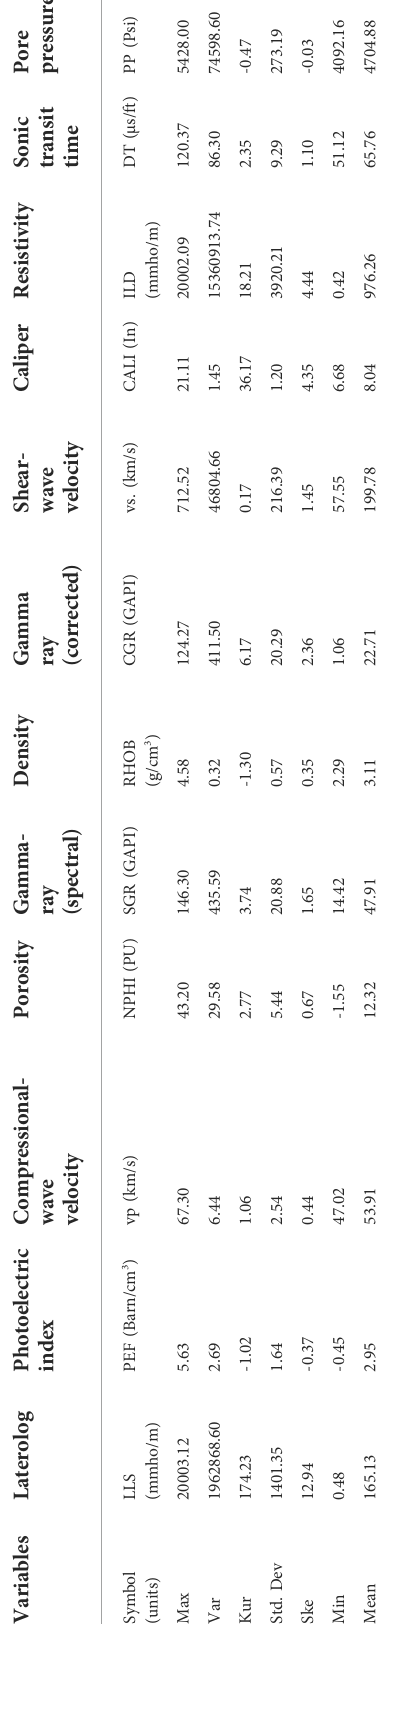
obtain and develop the GS-GMDH algorithm. During the T